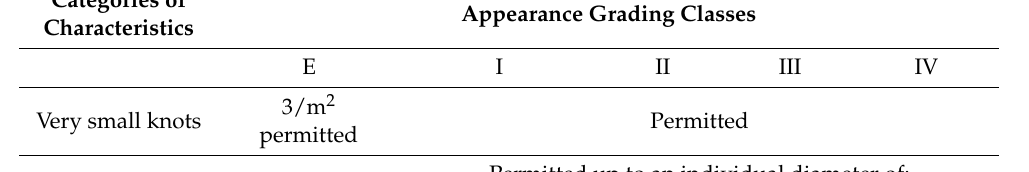
Table 3. Appearance grading classes from the EN 635-3 standard. Categories